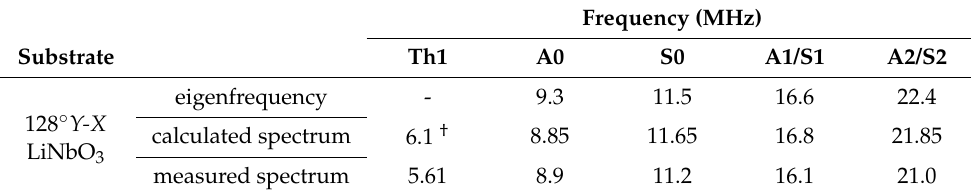
Table 3. Comparison of the calculated and measured frequencies excited by the IDT.